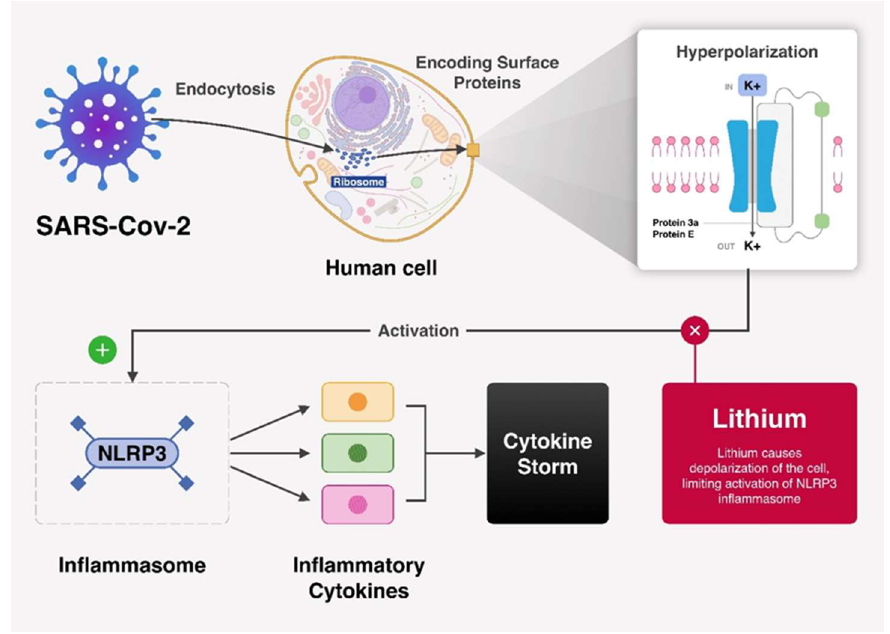
Figure 1. A theoretical scheme of how lithium depolarization interrupts the cascade that leads to NLRP3 activation.